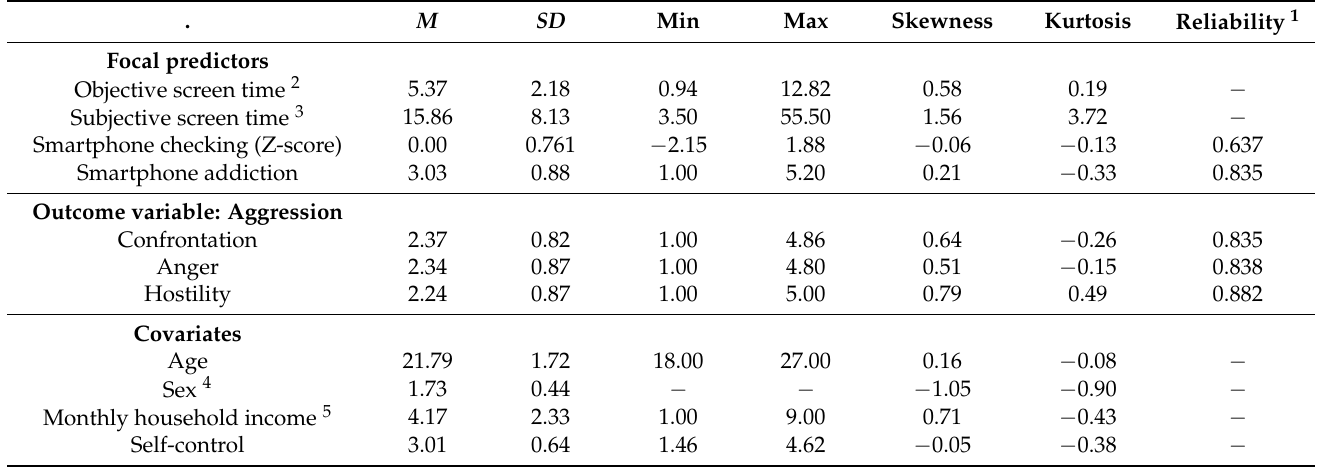
Table 1. Descriptive Statistics of All Variables and